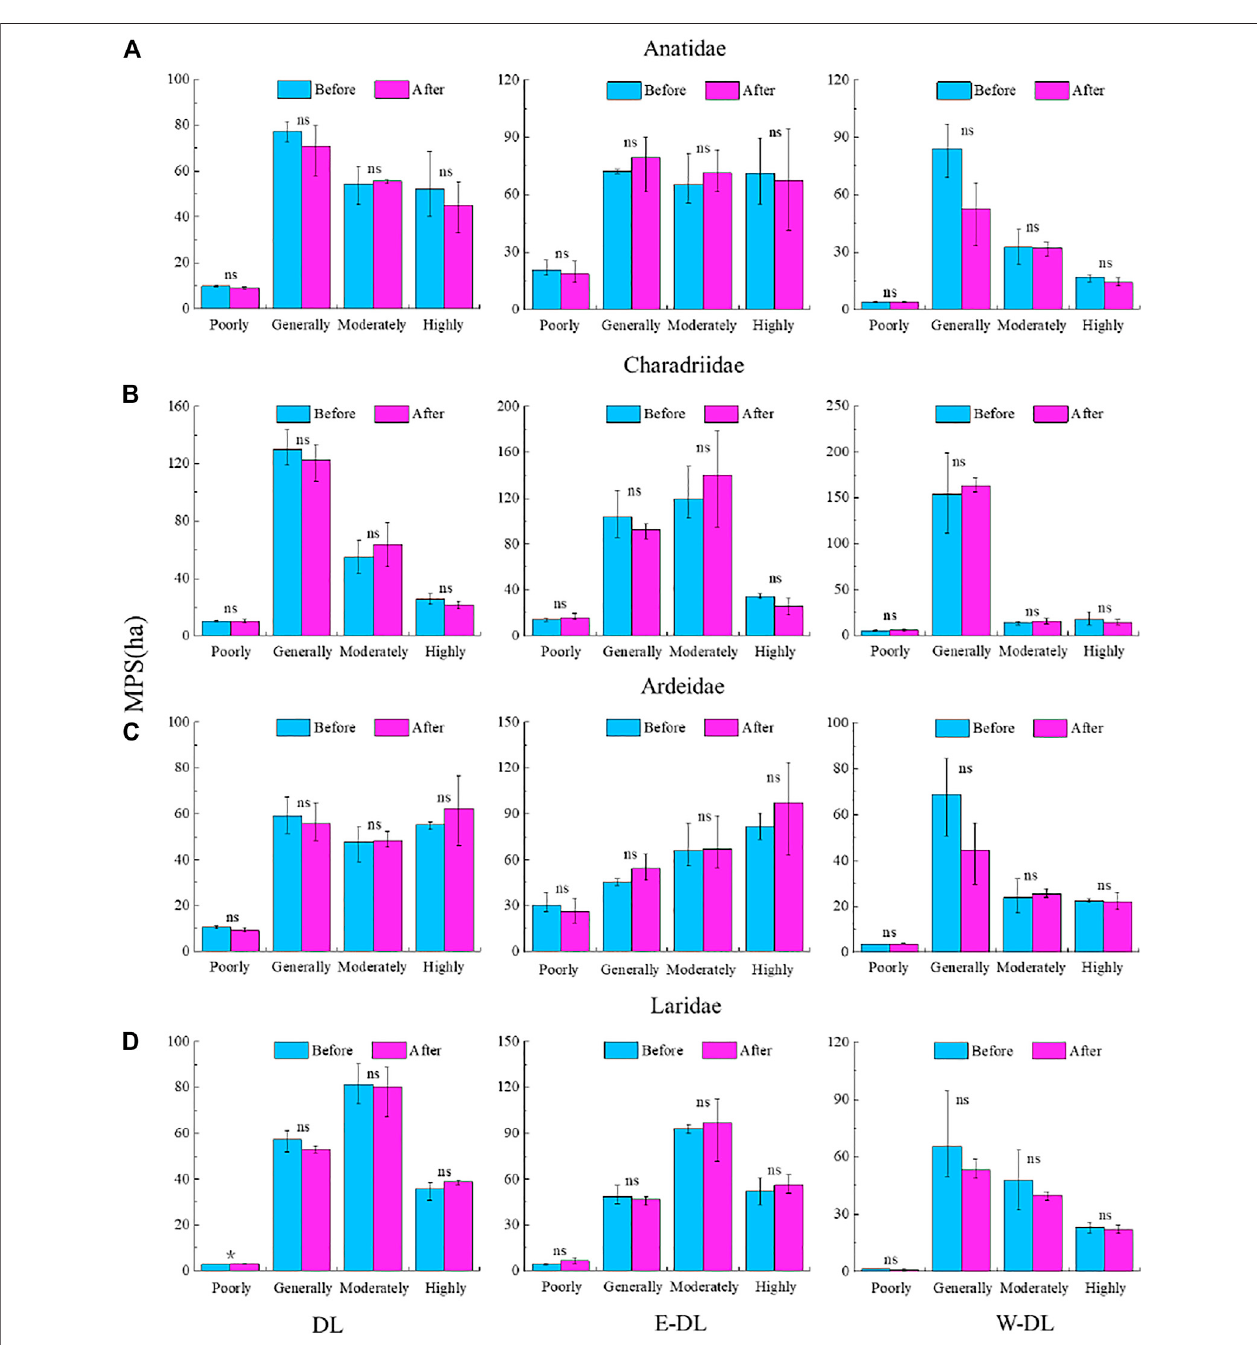
FIGURE 6 | The MPS (Mean patch size) ofeach grade of habitat suitabilityfor (A) Anatidae, (B) Charadriidae, (C) Ardeidae and (D) Laridae of before PER and after PER in DL, E-DL and W-DL respectively. Error bars around the mean represent the maximum and minimum values of this group of data respectively. The information of MPS in HL and S-DL are showing in Supplementary Figure S8